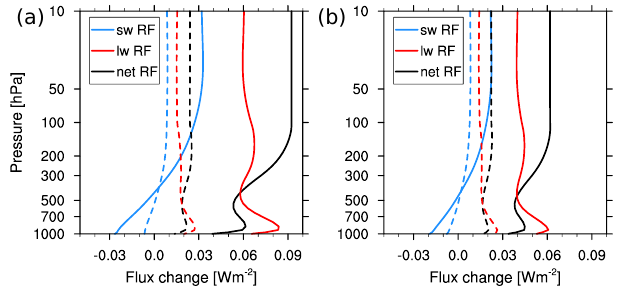
Figure 10. Vertical profile of globally averaged shortwave, long- wave, and net radiative O 3 forcing of (a) land transport and (b) ship traffic. The continuous lines give the results of the tagging method, and the dashed lines of the perturbation